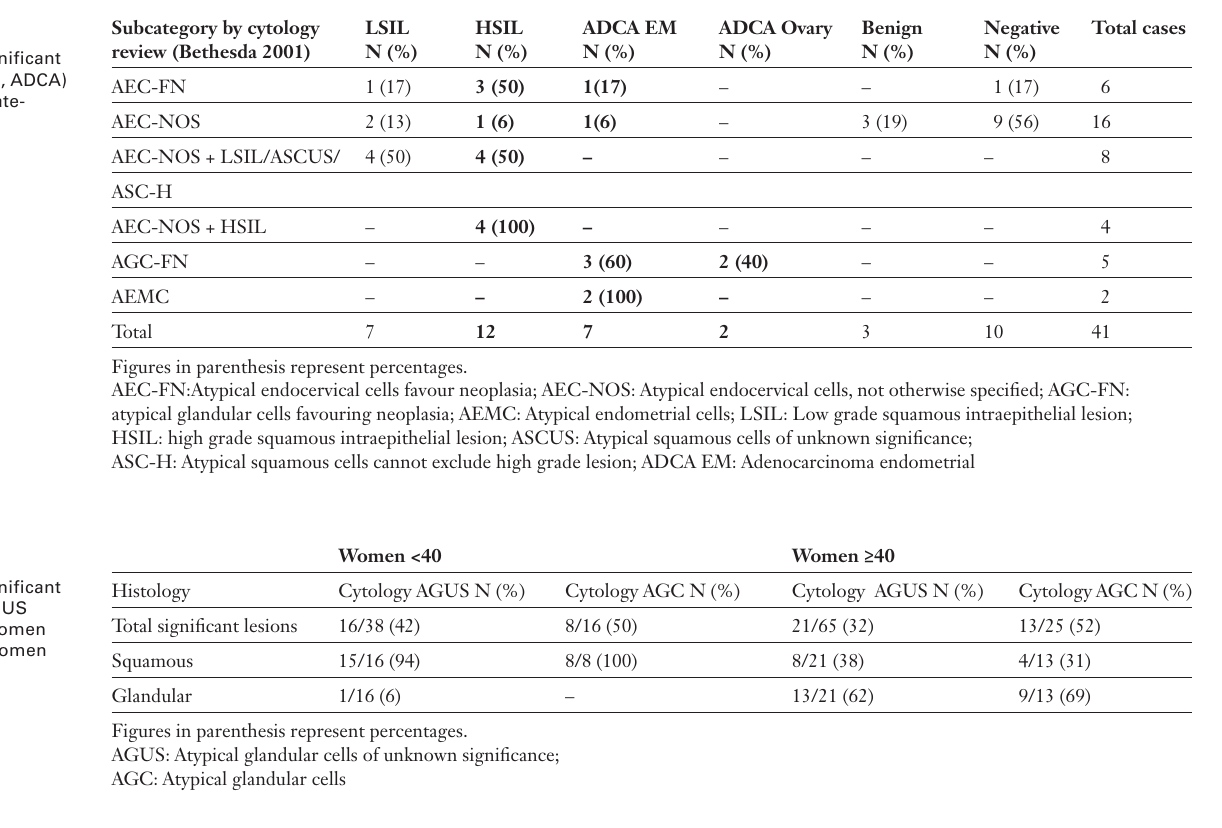
Figures in parenthesis represent percentages. AGUS: Atypical glandular cells of unknown significance; AGC: Atypical glandular cells